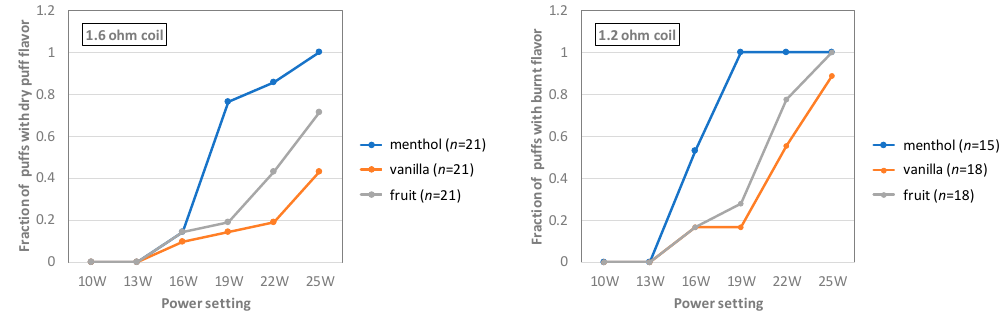
Figure 1. Human assessment of the presence of dry puff flavor at different power settings for each of the three e-liquid flavors tested and both coils. The vertical axis represents the fraction of all puffs for which the panelists reported dry puff flavor that was so intense they would normally not continue vaping. “ n ” represents the number of puffs assessed by the panel.